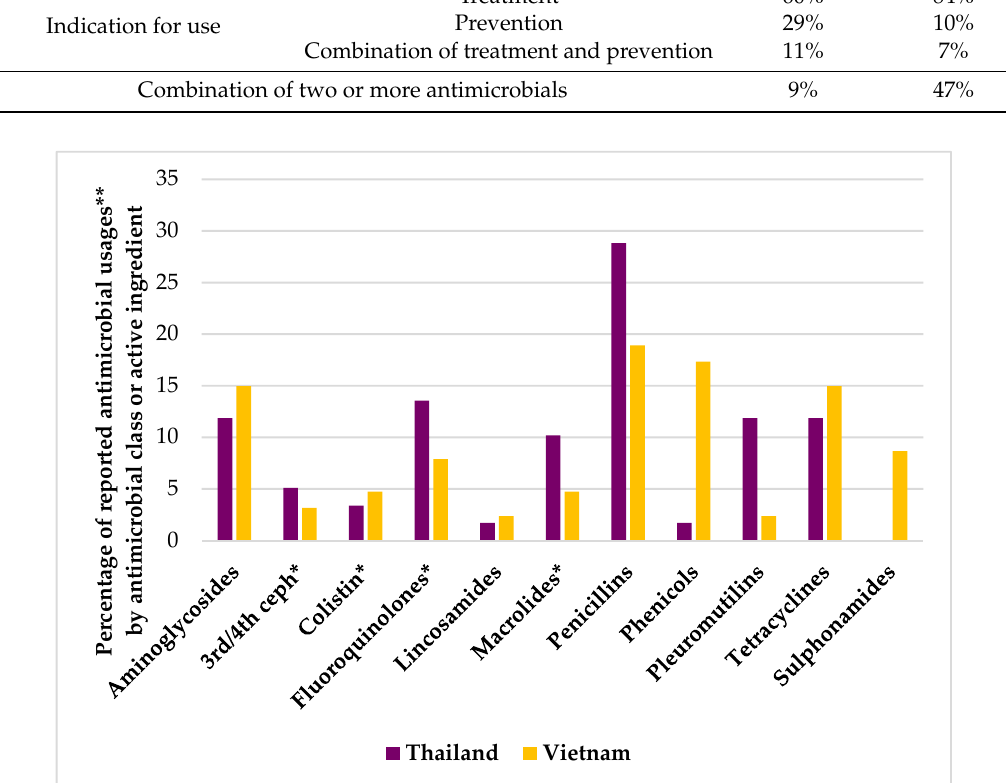
Figure 3. Reported antimicrobial usages by active ingredient (%) in a case study into antimicrobial use in pig production in Thailand and Vietnam. *Antimicrobial class classified by the WHO as the highest priority as critically important antimicrobial (HP-CIA). **A ‘reported antimicrobial usage’ was considered the use of an antimicrobial active ingredient or the use of the same active ingredient in a different formulation, as reported by the farmer. In the case of a combination of antimicrobial product, each active ingredient was counted as differently reported antimicrobial usage.